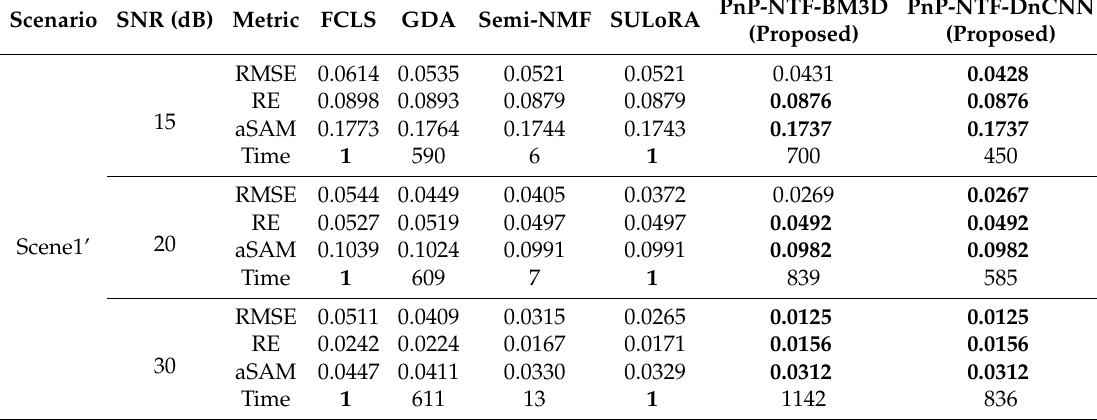
Table 1. Evaluation Results in ‘Scene1’ with different signal-to-noise ratios (SNRs) and time cost